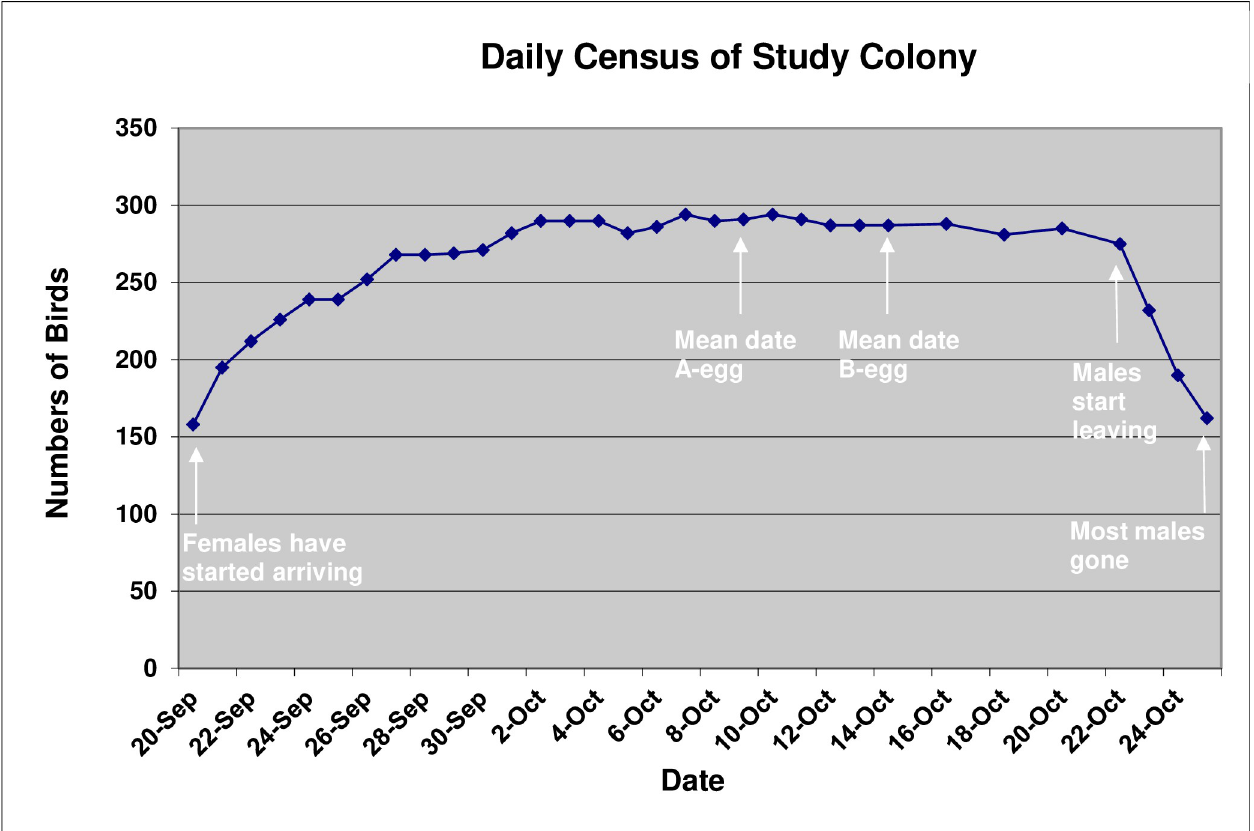
Fig 1. Daily census of number of erect-crested penguins in the Study